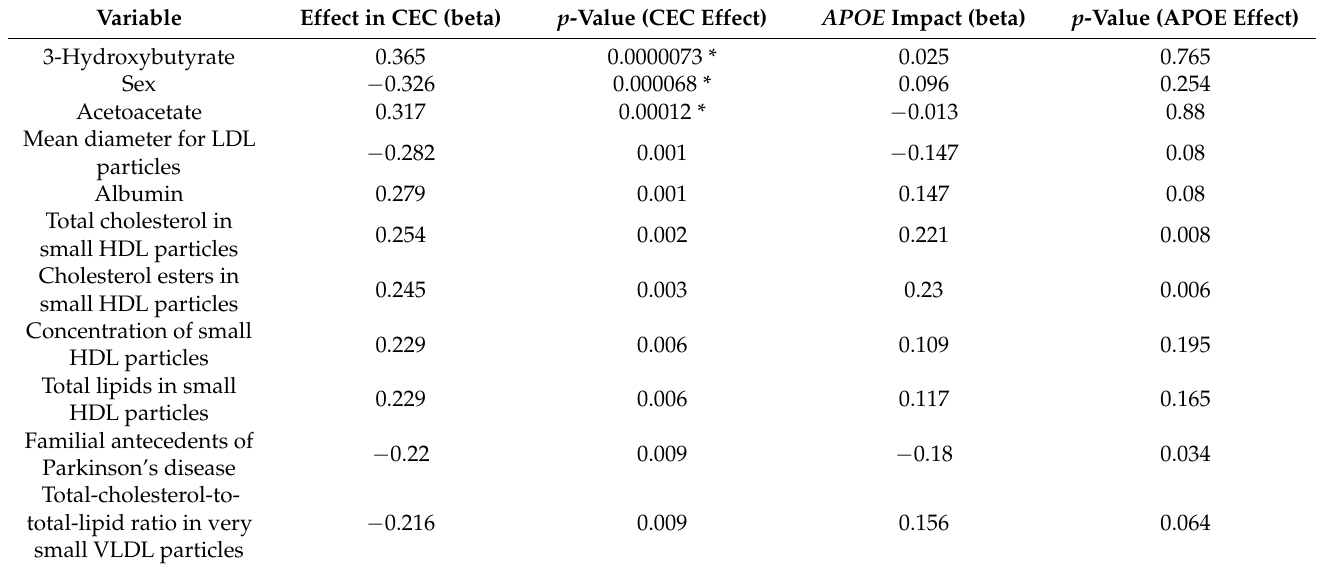
Figure 2. Global heatmap analyzing the patterns of correlations between plasma NMR features and APOE , SEX, and CEC. The details of the NMR notation are described in supplementary information. Table 1. Top variables associated to the cholesterol efflux capacity (CEC) in the studied population. The influence of the APOE genotype in the variables is also